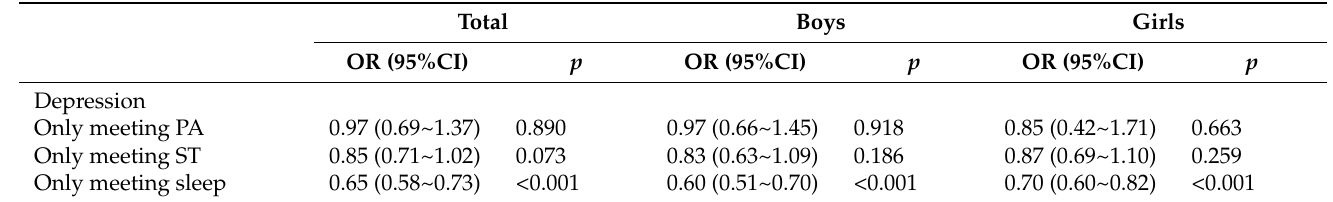
Table 3. Meeting one recommendation of the 24-HMG in relation to anxiety and depression in the